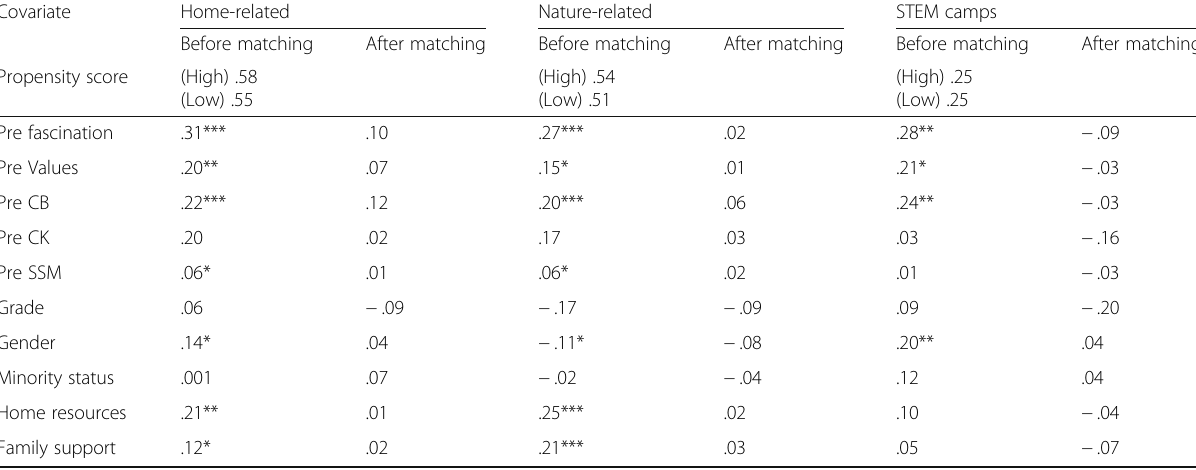
Table 8 Mean differences between matching model covariates before and after matching Covariate